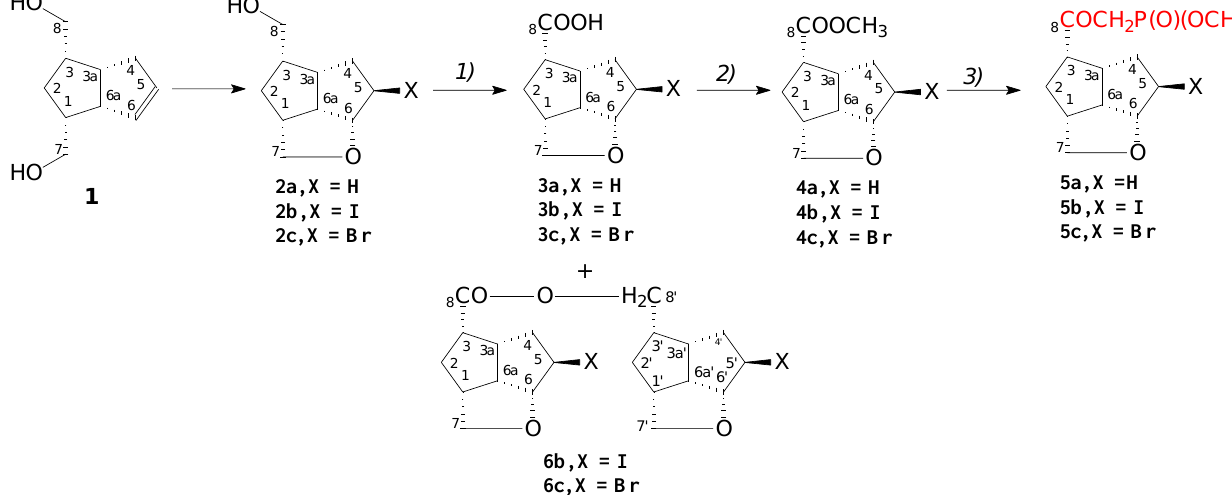
Scheme 1. Synthesis of pentalenofurane β -ketophosphonates 5a – 5c . Reagents and Conditions : (1) 2.4 M Jones reagent, acetone, − 15 to 0 ◦ C, 2a , 81.8% 3a ; with 2b , 85.15% 3b ; with 2c , 73.7% 3c , (2) MeOH, TsOH, rt, overnight, 86.4% 4a ; 92.4% 4b ; 81.0% 4c , (3) dimethyl methanephosphonate, n -BuLi, − 75 ◦ C to − 65 ◦ C, 88.0% 5a ; 78.6% 5b ; 83.3% 5c